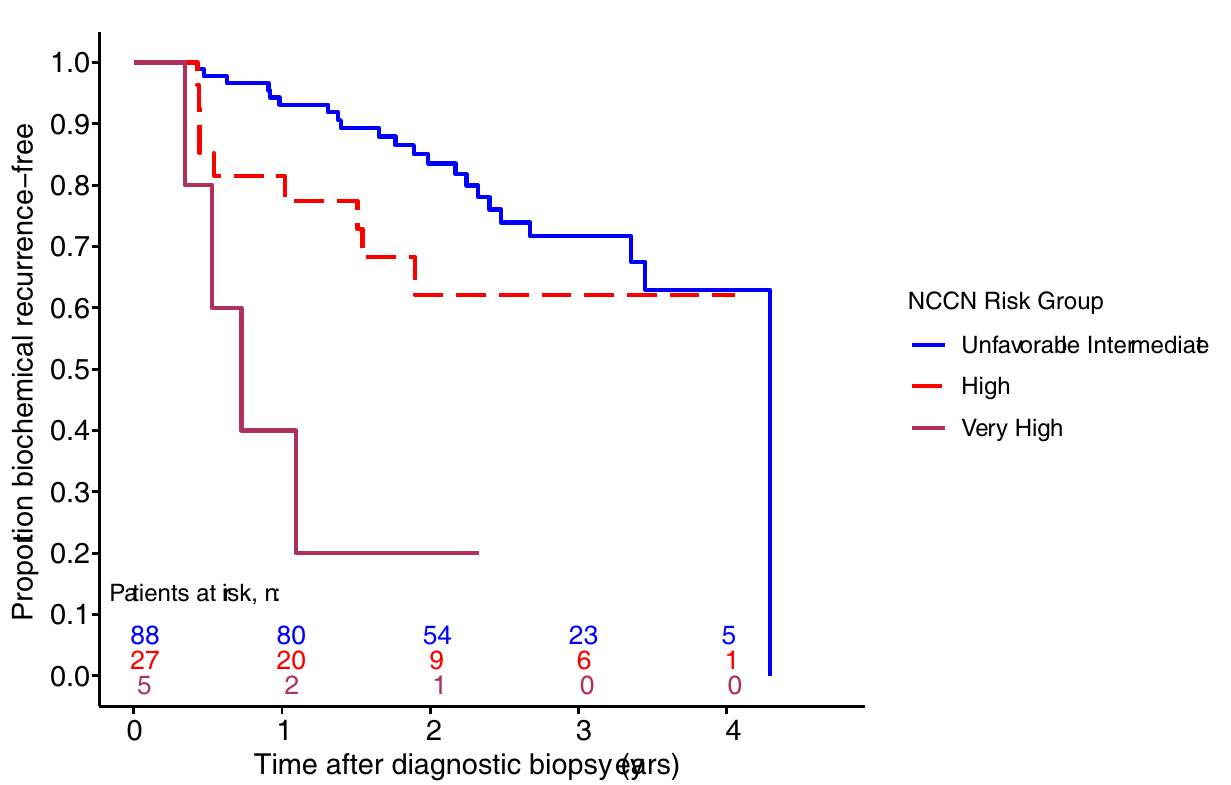
Fig 3. Kaplan-Meier curves stratified by NCCN risk group (n = 120). Kaplan-Meier curves showing the proportion of patients remaining free of biochemical recurrence from time of biopsy stratified by NCCN risk group. https://doi.org/10.1371/journal.pone.0273782.g003 All PH models use time from biopsy to align with previous work 7,11 . Sensitivity analyses using time from RP rather than biopsy to BCR provided similar results, which are presented in the Supplementary Materials (S2 and S3 Tables, S3 and S4 Figs).